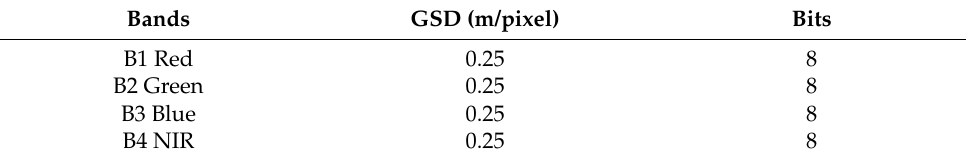
Table 1. Bands from PNOA. Bands GSD (m/pixel) Bits B1 Red 0.25 8 B2 Green 0.25 8 B3 Blue 0.25 8 B4 NIR 0.25